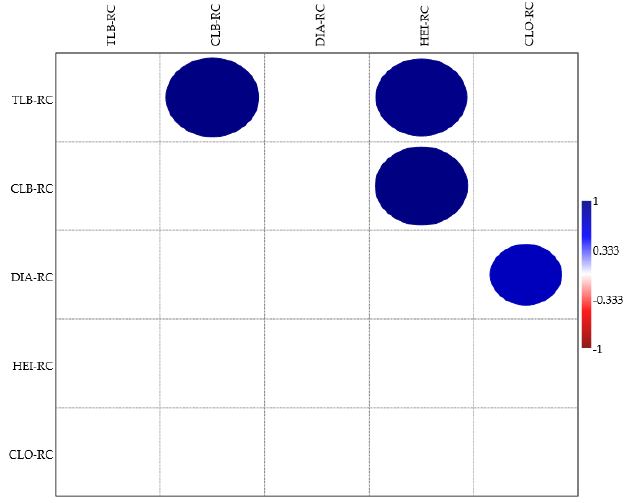
Figure 2. Pearson correlation between variables in radicchio chicory (RC) submitted to different concentrations of boiled chicken manure (BCM), Bokashi, and mineral fertilization in a greenhouse. Blue color represents the “+1” correlation coefficient and red color represents the “−1” correlation coefficient. Only significant ( p < 0.05) correlations were shown. Total leaf biomass (TLB), commercial leaf biomass (CLB), plant diameter (DIA), plant height (HEI), and chlorophyll index (CLO).